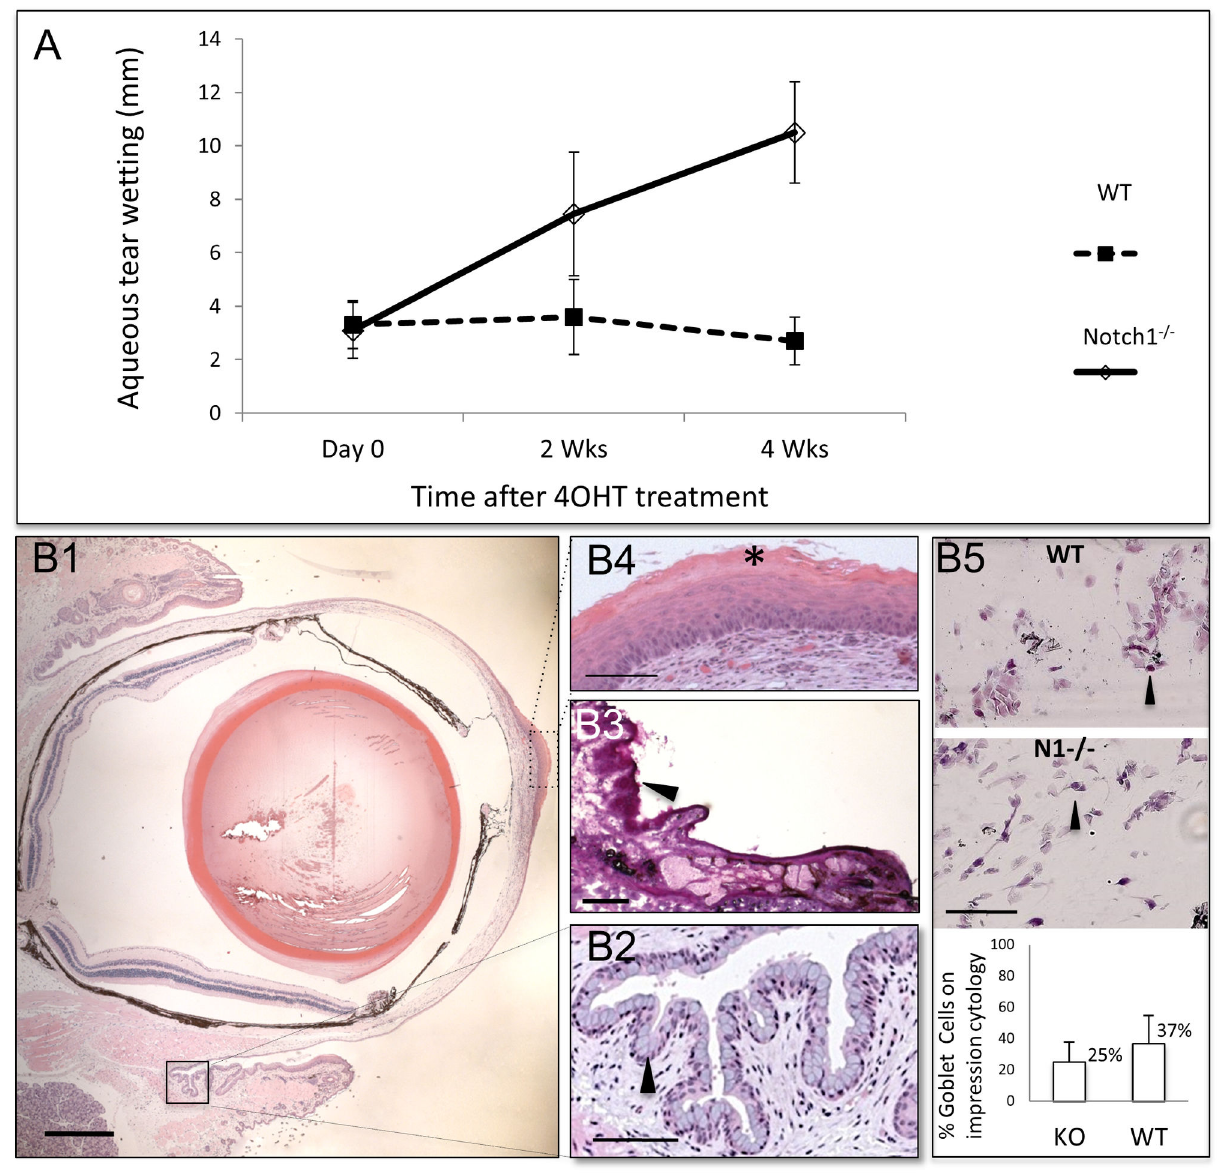
Figure 4. Aqueous tear production is increased and goblet cells are intact in conditional Notch1 -/- mice. Aqueous tear measurement by phenol thread test in millimeters at baseline, 2 and 4 weeks after treatment with 4-OHT in Notch1 -/- and WT littermates. The mean aqueous tear production in Notch1 -/- eyes was found to be significantly higher than WT at 2 (7.4 ± 2.3 mm versus 3.6 ± 1.4, P = 0.001) (N=10 per group) and 4 weeks (10.5 ± 1.8 mm for Notch1 -/- compared to 2.7 ± 0.9 mm in WTs, P <0.001) after the treatment (A). Goblet cells (arrow heads) are visualized by H&E (B1, B2) and PAS (B3) staining in the conjunctival fornix of conditional Notch1 -/- mice which have developed keratinization (asterisk) of the central corneal epithelium (B4). Impression cytology of Notch1 -/- and WT lids showed no significant difference in the ratio of goblet to epithelial cells (mean ratio of 36.7±18% in N1 -/- and 25.1±16.6% in WT, P = 0.118). scale bar: 500 µm (B1), 100 µm (B2, B4, B5) and 200 µm (B3).